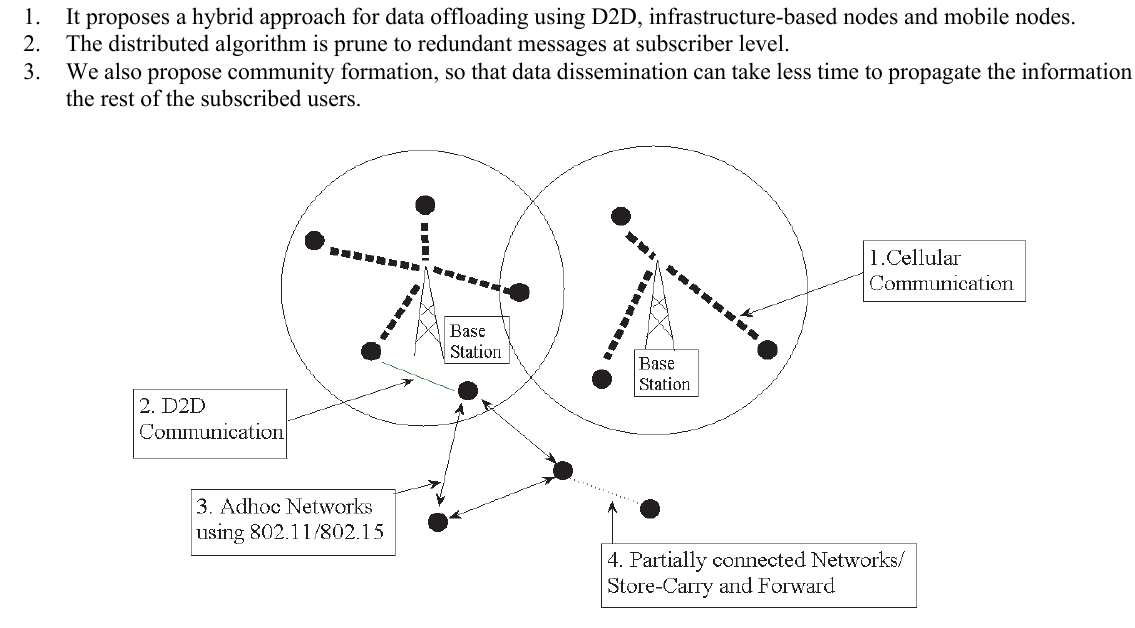
Fig. 1. Hybrid model of D2D Communication with ad-hoc nature in partially connected